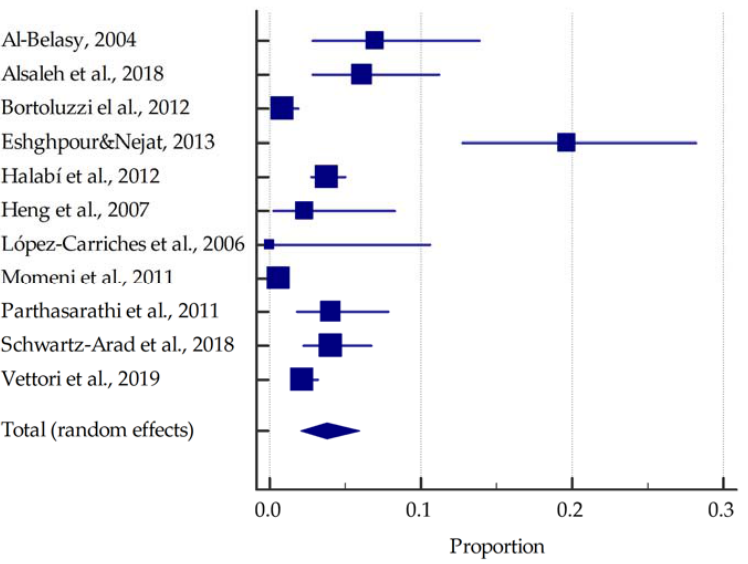
Figure 4. Forest plot presenting the summarised prevalence of dry socket among non-smokers [21–31]. Altogether, regular smoking is associated with a more than three-fold increase in the odds of dry socket after tooth extraction (Figure 5).